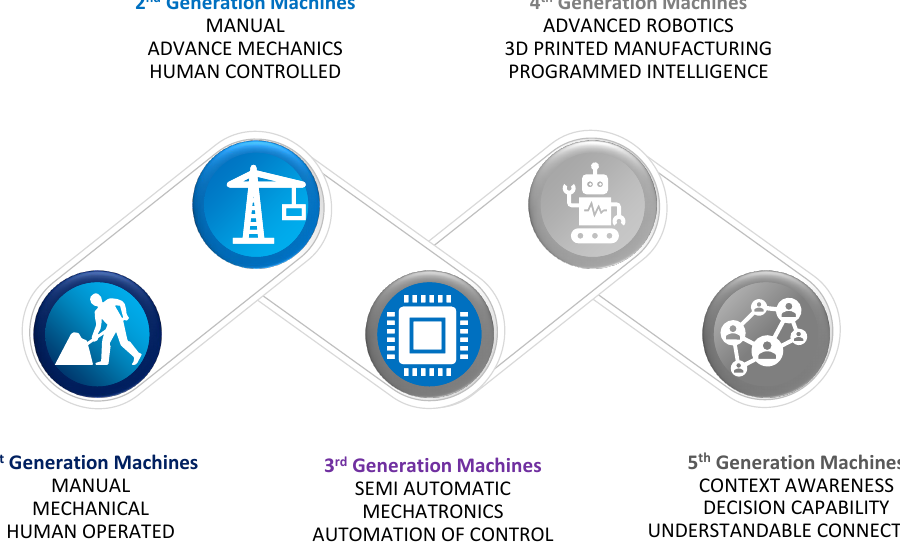
Figure 3. Machine technology